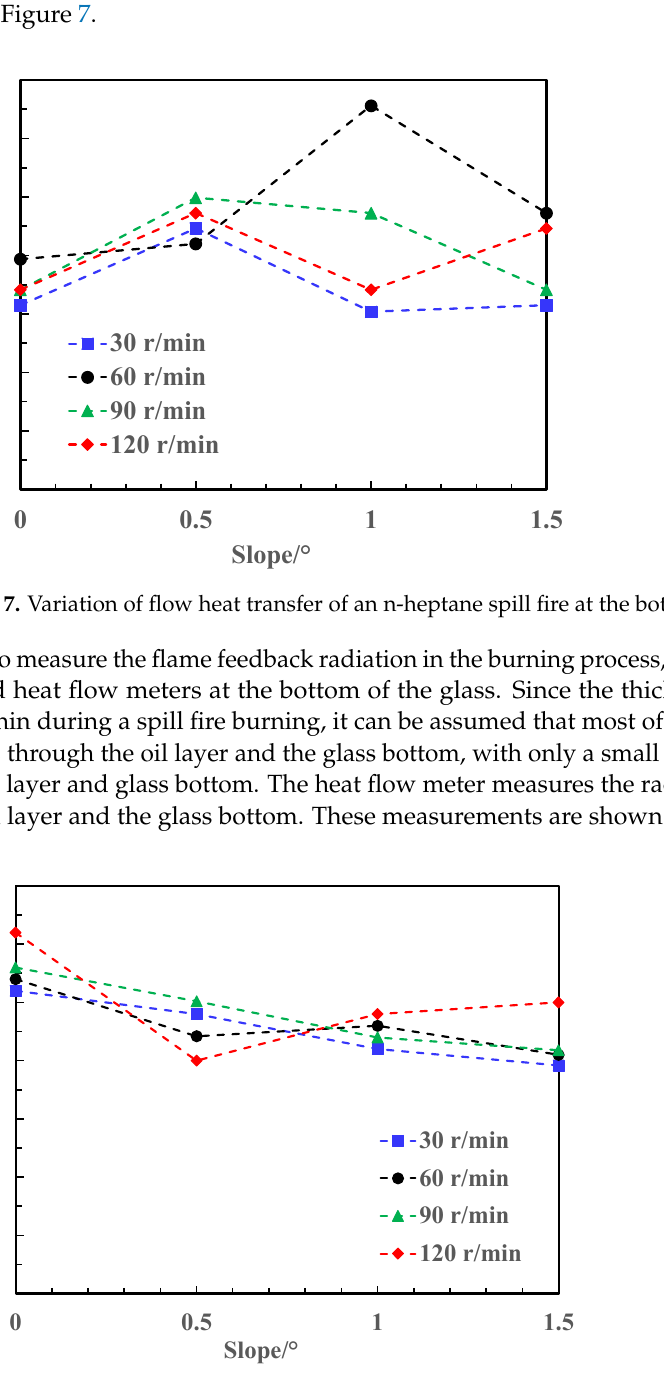
where 𝑞 (cid:3033) is the radiant heat flux feedback by the flame to the oil surface (kW/m 2 ), h is the